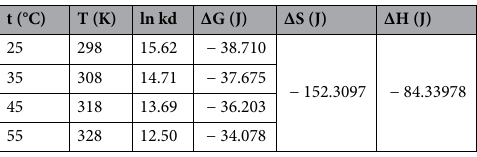
Table 4. Thermodynamic parameters for adsorption of (PTZS-CN) dye (25 mg/L) at pH = 9 for 30 min.